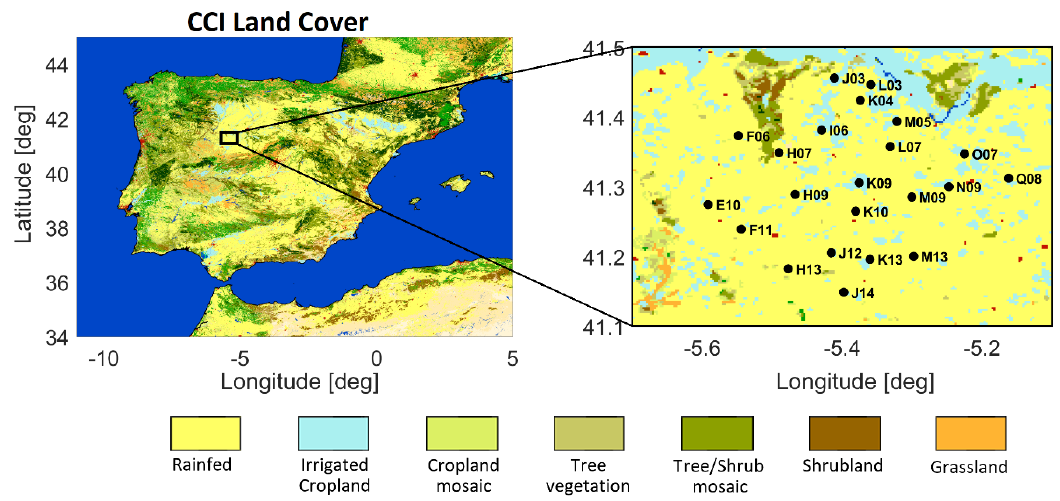
Figure 1. CCI land cover map (at 300 m) over the Iberian Peninsula (left) and a close-up of the REMEDHUS area (right). Black dots depict the 20 in situ SSM stations of the REMEDHUS network available for the study period (from April 2015 to December 2017). The distribution of the land cover within the REMEDHUS area is: agriculture, 95.45% (cropland, 75.44%; irrigated, 16.11%; other, 3.90%); forest, 2.70%; grassland, 0.63%; wetland, 0%; settlement, 0.26%; and other, 0.95%.